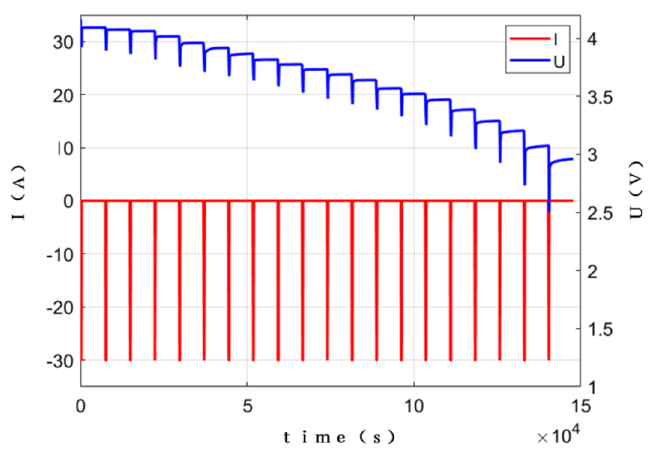
Figure 3. Test voltage and current